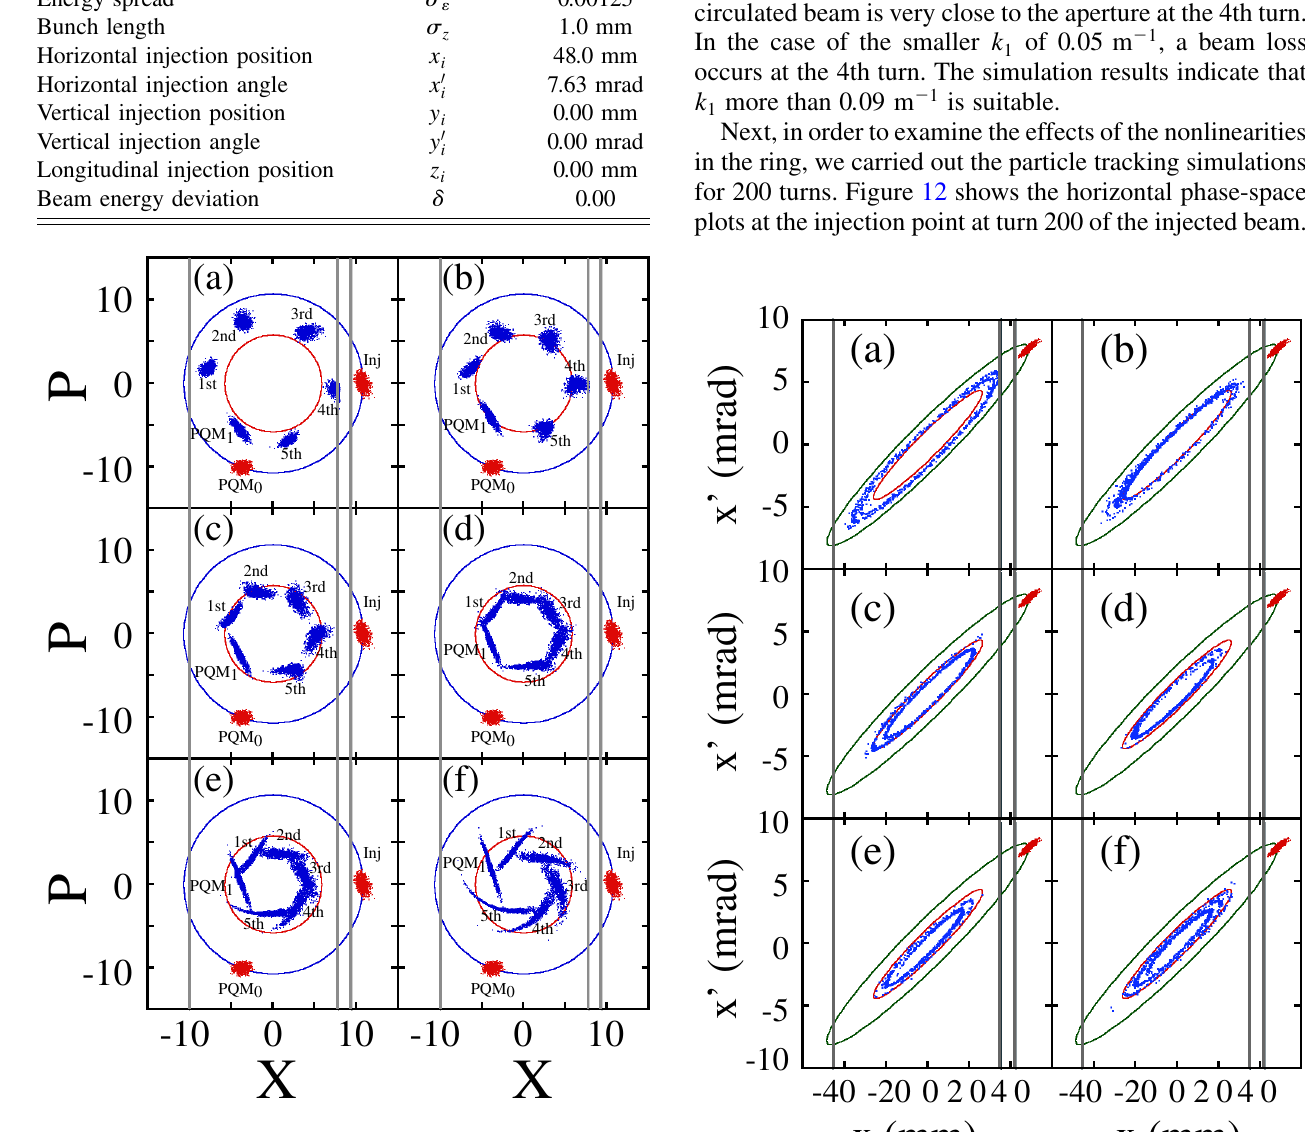
FIG. 11. (Color) Normalized horizontal phase-space plots of the injected beam and the circulated beam after the kick until five of (a) 0.989, FIG. 12. (Color) Horizontal phase-space plots of the circulated turns are displayed for the normalized strengths K 1 (b) 1.384, (c) 1.780, (d) 2.175, (e) 2.571, and (f) 2.967, which beam at turn number 200 at the injection point are displayed for of 0.05, 0.07, 0.09, 0.11, of (a) 0.05, (b) 0.07, (c) 0.09, (d) 0.11, correspond to the physical strengths k the physical strengths k 1 1 0.13, and 0 : 15 m (cid:5) 1 , respectively. The beam just before the kick (e) 0.13, and (f) 0 : 15 m (cid:5) 1 . The injected beam is also repre- and PQM , due to the PQM is also represented by PQM sented. Three solid lines indicate horizontal physical apertures, 0 1 respectively. Three solid lines indicate normalized horizontal which correspond to the vacuum chamber at the injection point. physical apertures. The blue and red solid circles represent the The green and red solid ellipses represent the injection invariant W of 112 : 5 mm mrad and the reduced invari- of 112 : 5 mm mrad and the reduced invariant W injection invariant W i i of 33 : 0 mm mrad , respectively. ant W 33 : 0 mm mrad , respectively. 1